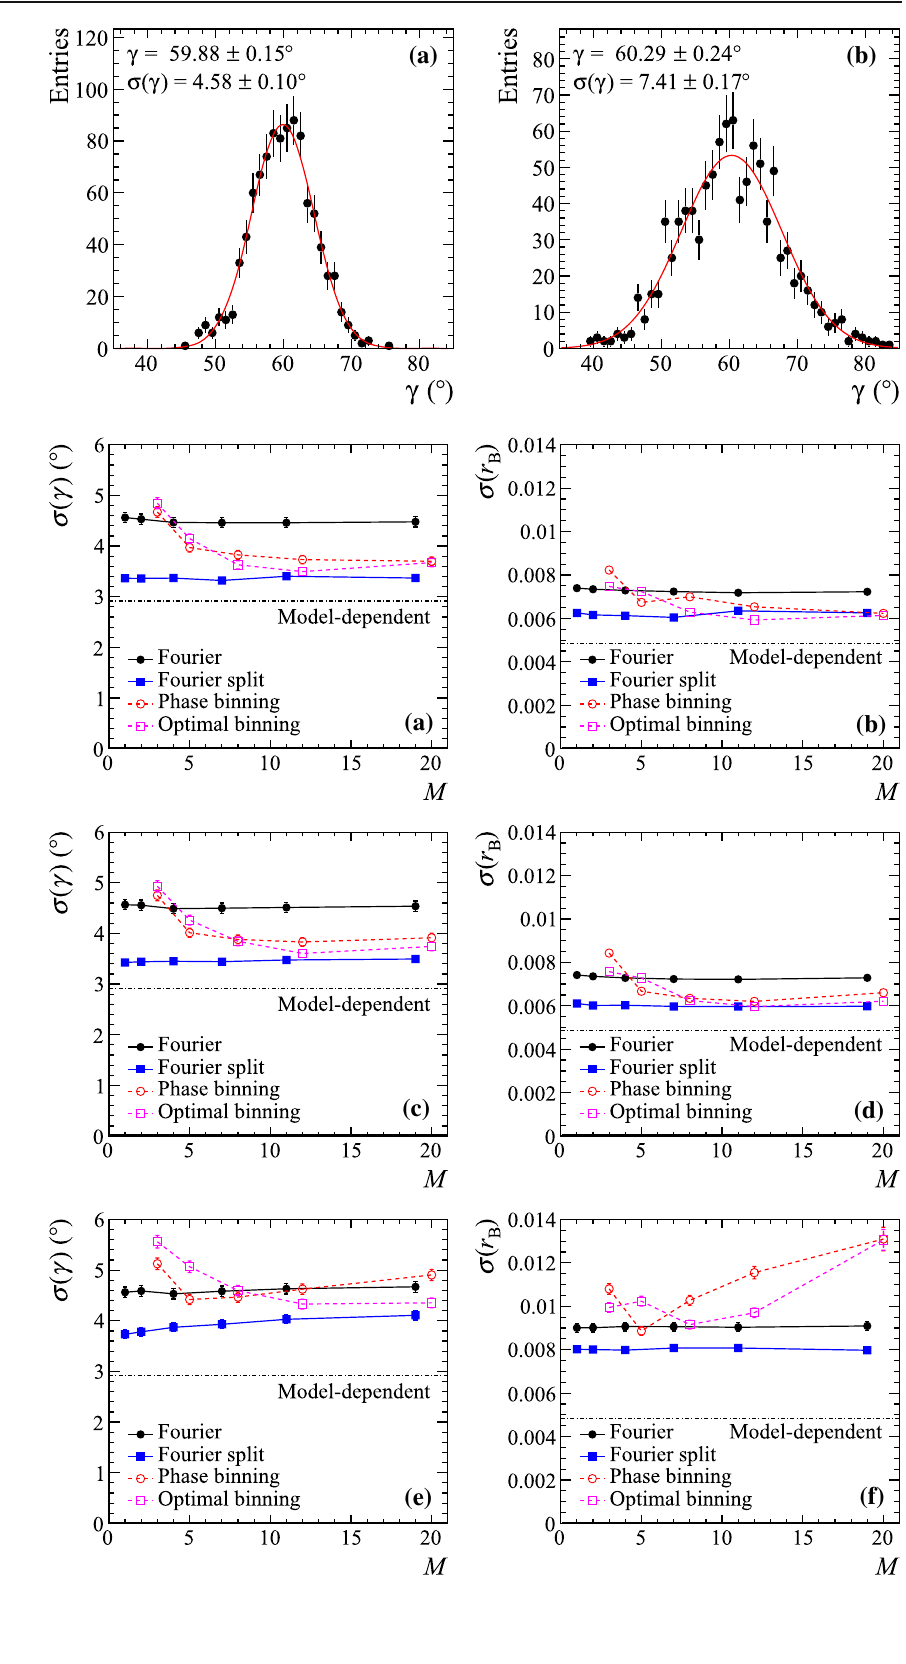
Fig. 5 Distributions of the reconstructed value of γ in pseudoexperiments with the a baseline and b reduced π + π − model used for D → K 0 S phase-difference calculation. Points are histograms of fit results, and the solid red line is the result of a fit with Gaussian distribution. The numerical results of the Gaussian fit are also reported